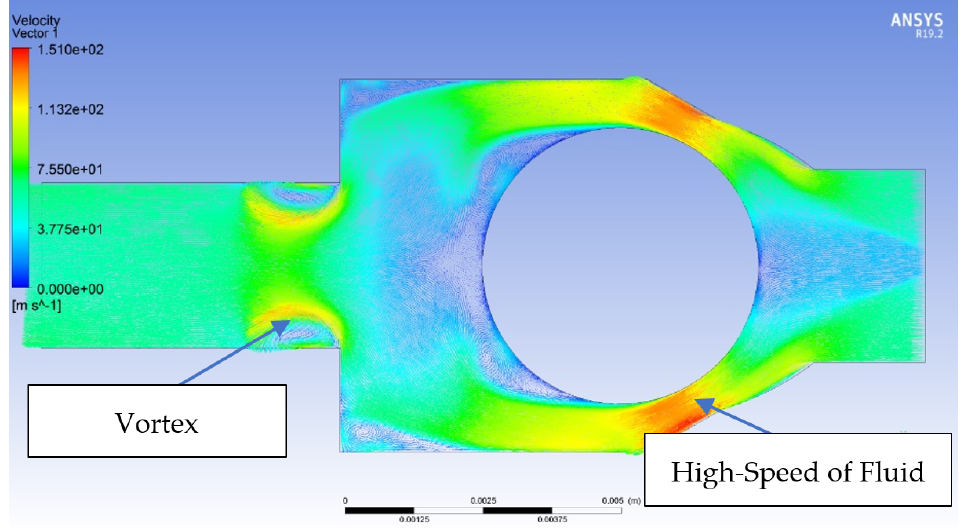
Figure 15. Velocity CFD: Conical Seat Valve: x = 1.005 [mm], pdn = 2000 [bar] and pup = 2100 [bar].